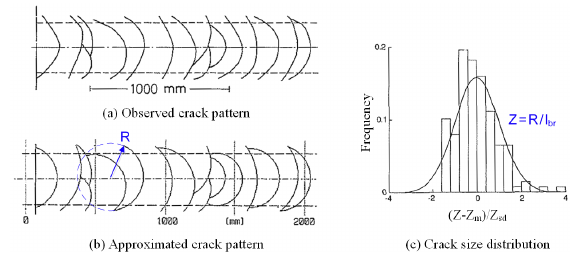
Figure 10: An example of the observed and approxi- mated crack size distributions in the model test of ice-cone interaction (Courtesy: Izu- miyama et al. (1992)).